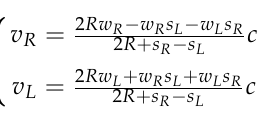
Figure 3. The relationship between